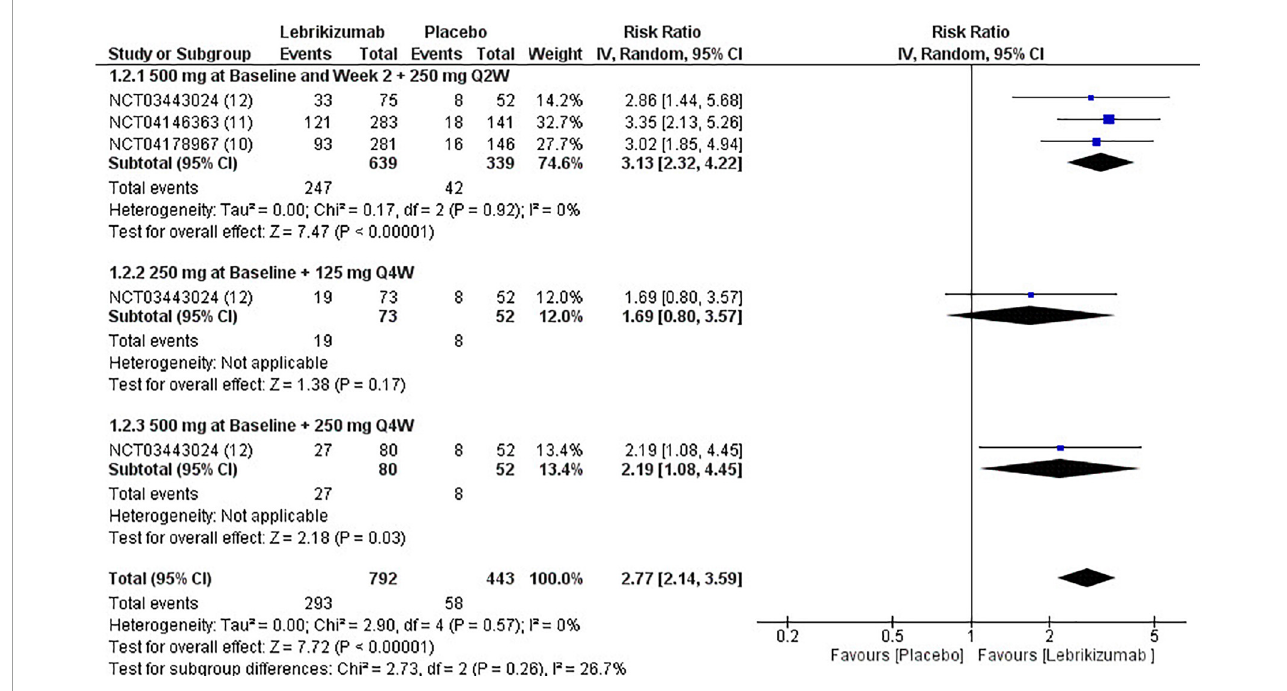
FIGURE6 Forest plot of IGA score. CI, confidence interval; IV, inverse variance; RR, risk ratio; Q2W, every 2 weeks; Q4W, every 4 weeks.